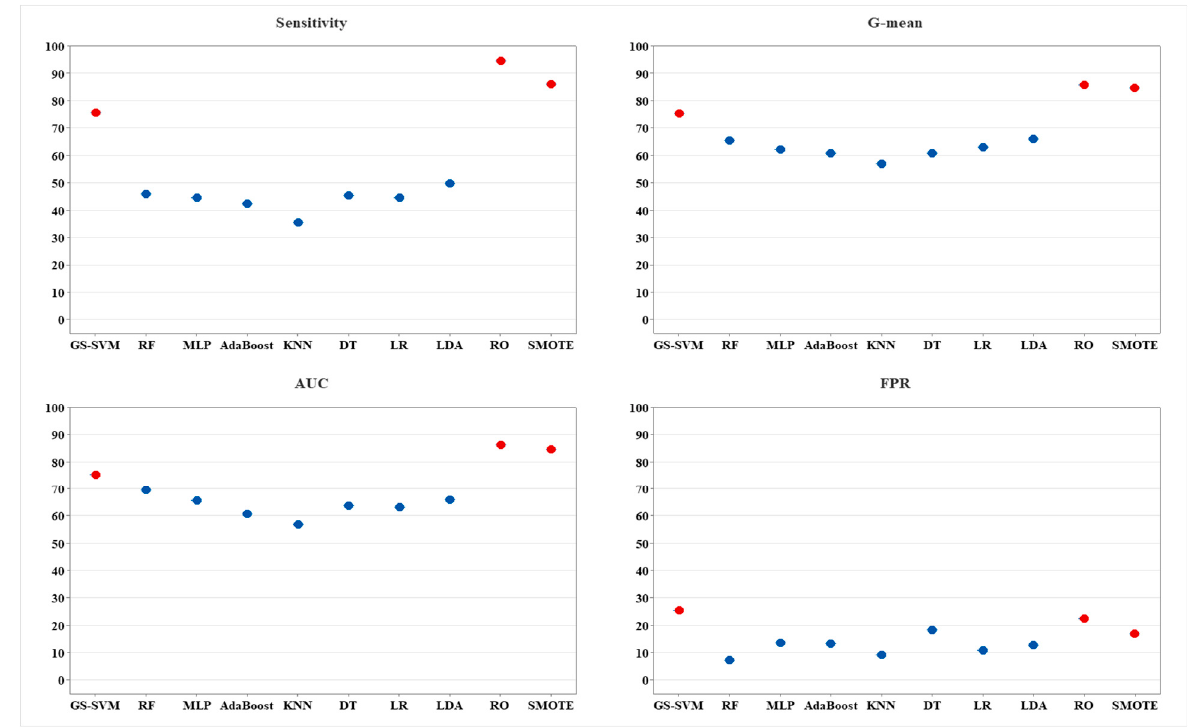
Figure 7. Comparison between GA-CS-SVM and balancing using RO.